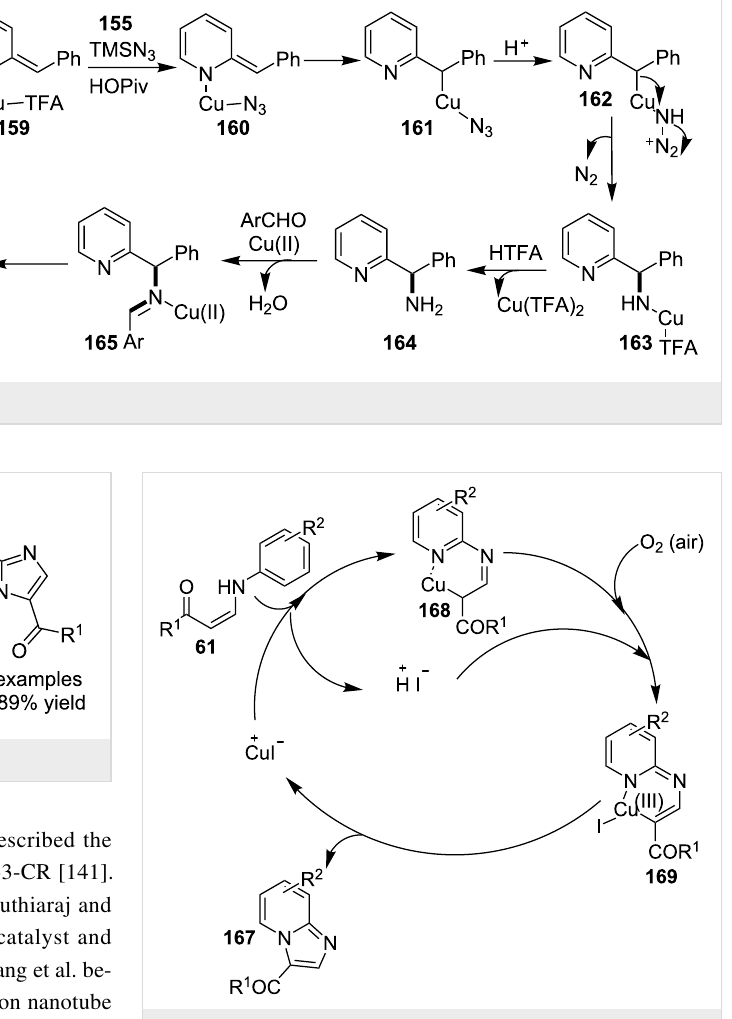
Scheme 60: Probable reaction mechanism involving sp 3 C–H amina-